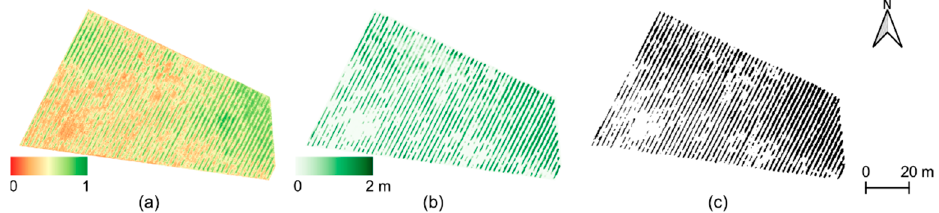
Figure 6. Inputs used in QVigourMap in the first vineyard flight campaign: the NDVI ( a ), CSM ( b ) and the resulting segmented vegetation used for the calculation of the vigour map ( c ).